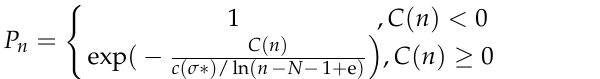
n ) = g ( x nearest ) + η